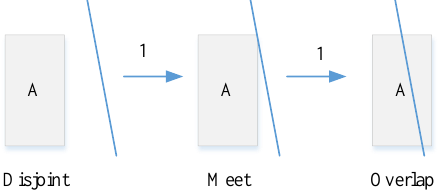
Figure 1 The definition of the step of topological transitions